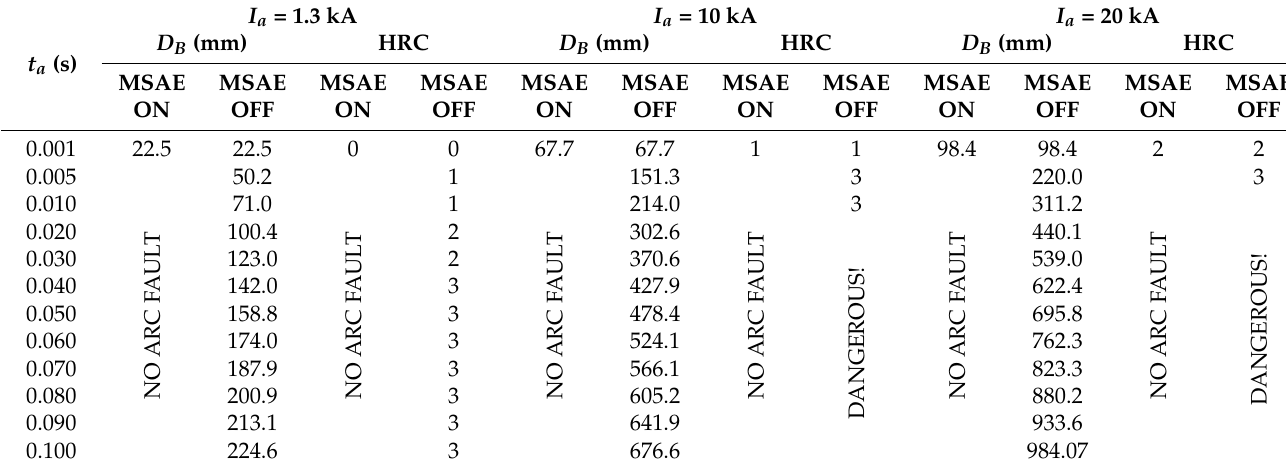
Table 6. The expected calculation parameters (according to IEEE 1584) of the FPB and hazard categories for the three arc current